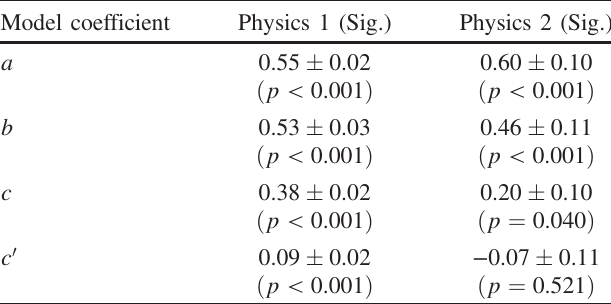
TABLE IV. Linear regression model coefficients. Means with 1 standard error are shown for both the Physics 1 and Physics 2 populations for each regression coefficient from Fig. 1.